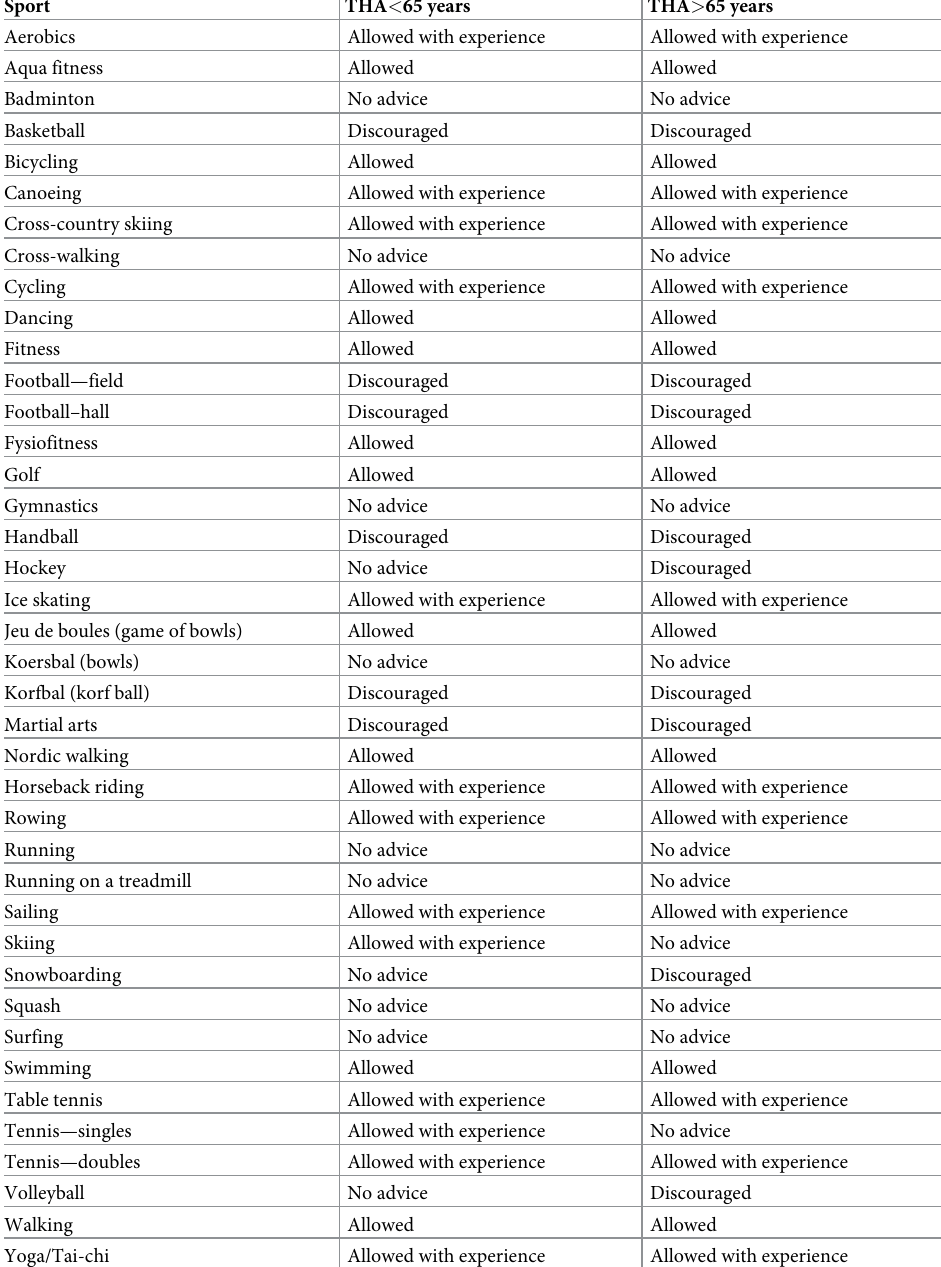
Table 1. Sport advice after THA. Sport